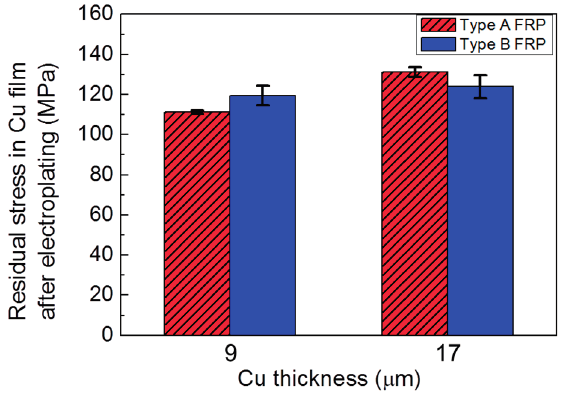
Figure 8. Comparison of residual stress in Cu film after electroplating of type A and B FRP specimens with 9 and 17 μ m Cu